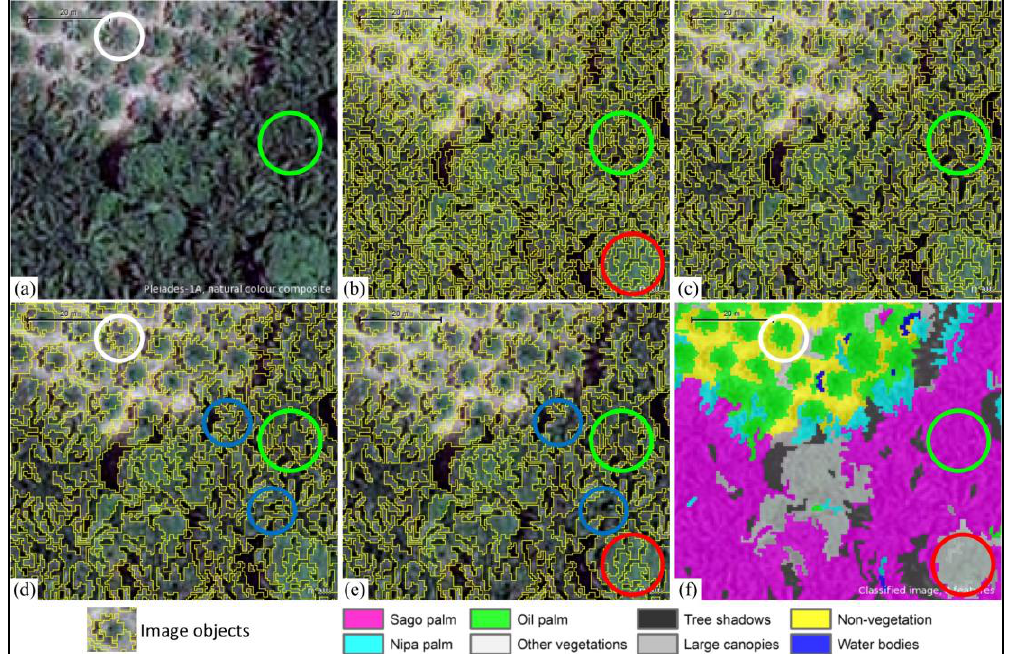
Figure 4. A series showing ( a ) a subset of the Pleiades-1A imagery; ( b ) first segmentation level of applying the MRS algorithm with 20 scale parameters; ( c , d ) second and third segmentation levels of applying the MRS algorithm with 30 and 40 scale parameters, respectively; ( e ) fifth-level segmentation applying the spectral difference algorithm and image object fusion algorithm; and ( f ) classified image using eight features.